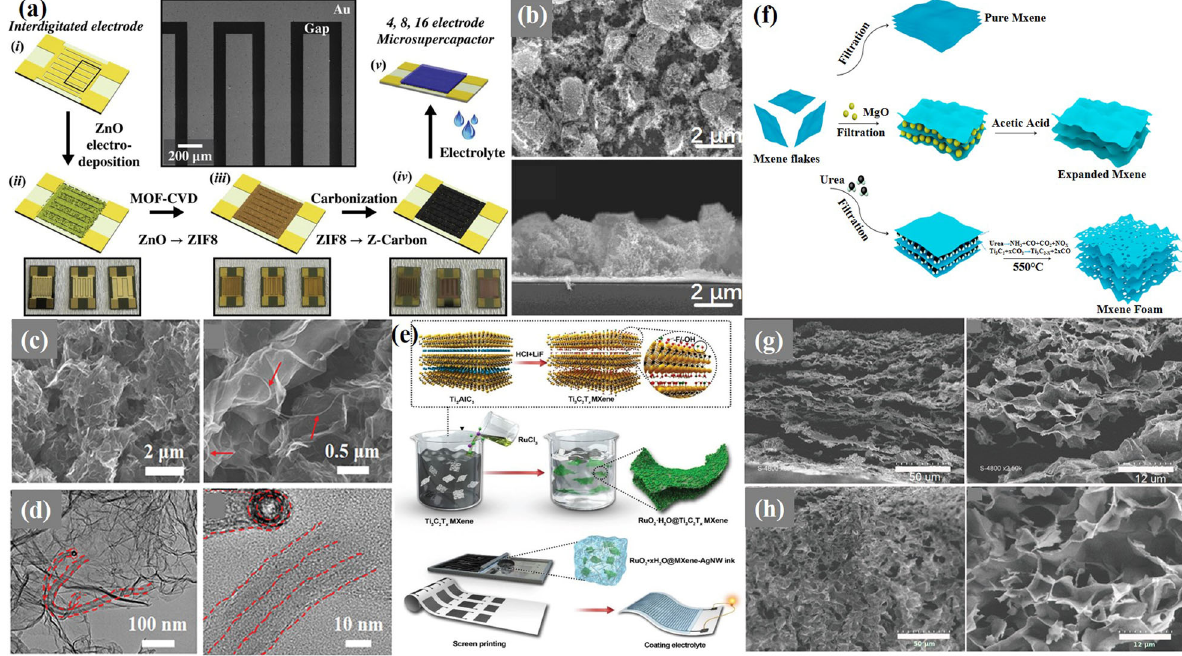
Fig. 5 Electrode materials optimization. a Schematic illustration of fabrication process for MSCs. b Top-view and cross-sectional SEM images of nanoporous carbon fi lm. c Top view and d cross-sectional SEM images of graphene-CNT electrodes at different magni fi cations (the red part indicates the CNTs between graphene sheets). e Schematic illustration of the process for screen-printed RuO 2 ·xH 2 O@MXene – Ag NW nanocomposite ink-based MSCs. f Synthesis scheme of the preparation of various forms of MXene. Side views from SEM images of g expanded MXene and h Mxene foam. a , b Reproduced with permission 92 (Copyright © 2019, Elsevier). c , d Reproduced with permission 93 (Copyright © 2020, John Wiley and Sons). e Reproduced with permission 113 (Copyright © 2019, John Wiley and Sons). f – h Reproduced with permission 115 (Copyright © 2020,